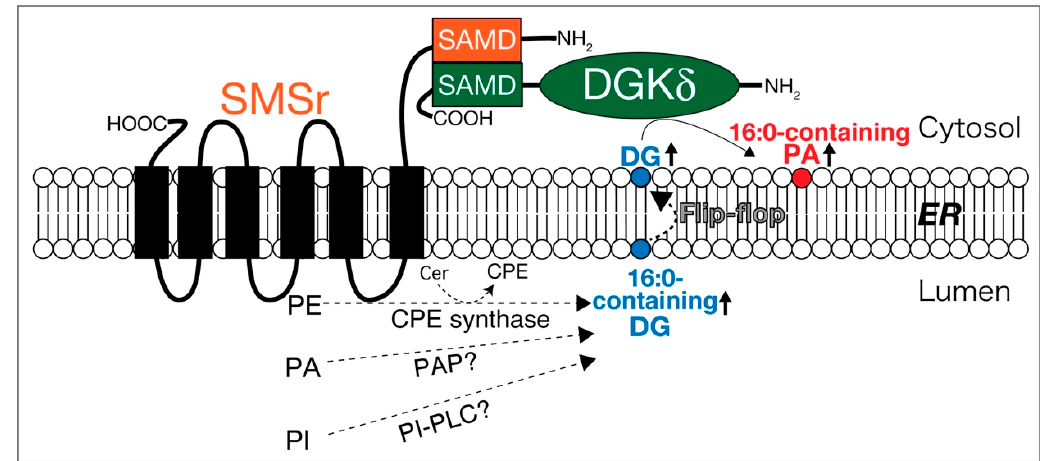
Figure 4. SMSr interacts with DGK δ and supplies DG. SAMD, SAM domain; Cer, ceramide; CPE, ceramide phosphoethanolamine; ER, endoplasmic reticulum.